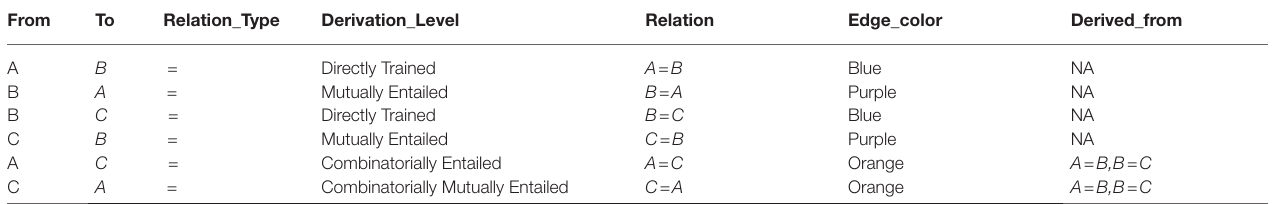
TABLE 1 | RelationTrain output for three stimulus equivalence network.